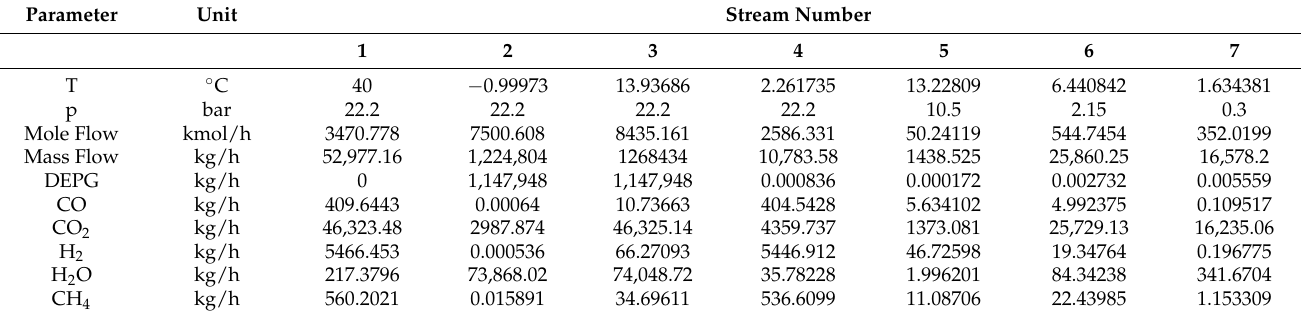
Table A8. Mass/Mole flows of Selexol process for BIR outlet gas with temperature and pressure state.